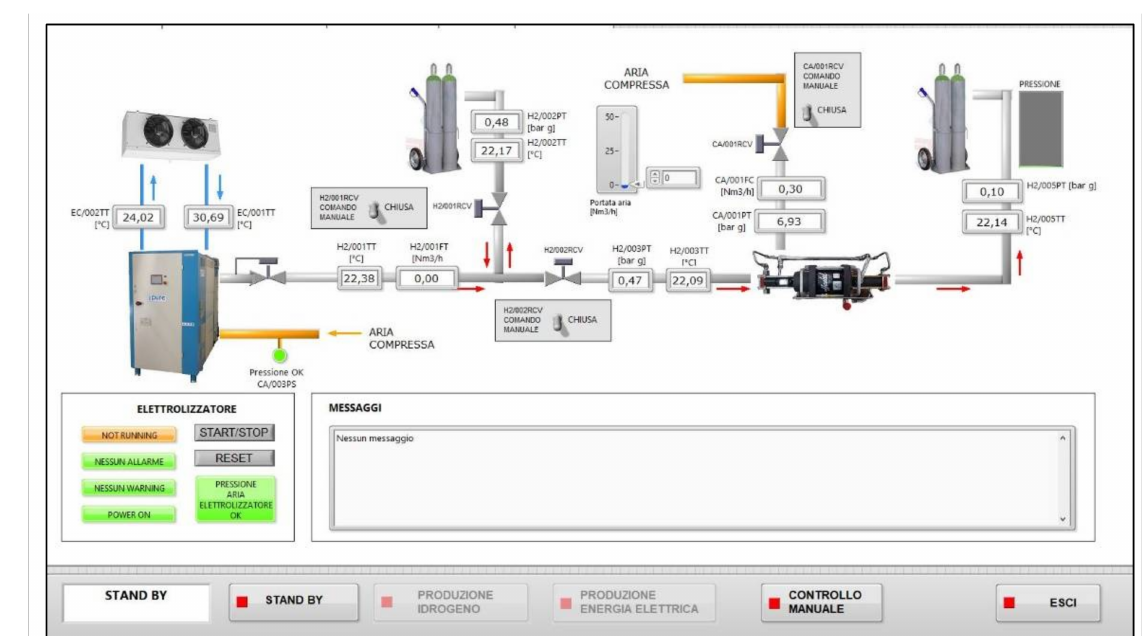
Figure 3. Hydrogen production and storage plant automation system main